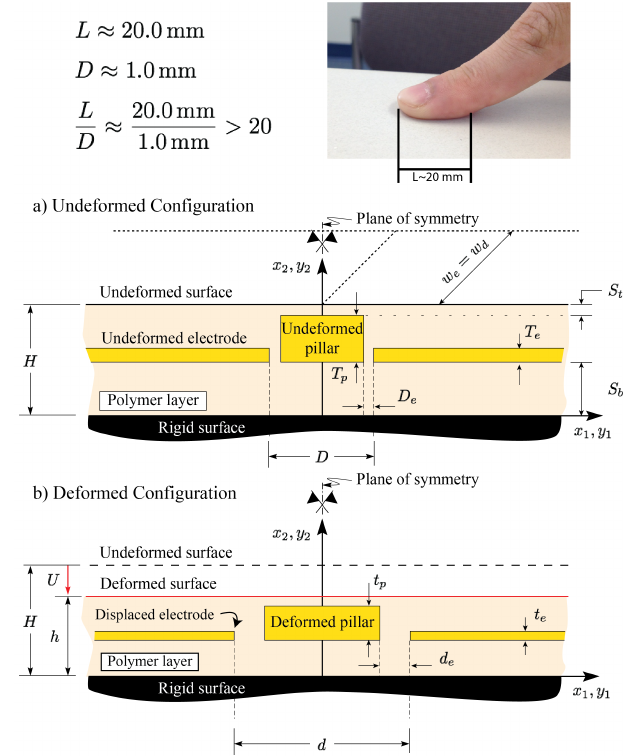
Figure 1. A schematic of the tactile unit-sensor designed and fabricated in [48]. Undeformed (reference) configuration is shown in ( a ); while the deformed (current) configuration is shown in ( b ). Due to typical large contact length-electrode spacing ratios, the mechanics of the elastomeric layer in the vicinity of the symmetry plane can be modeled as uniform compression of an infinitely long layer.